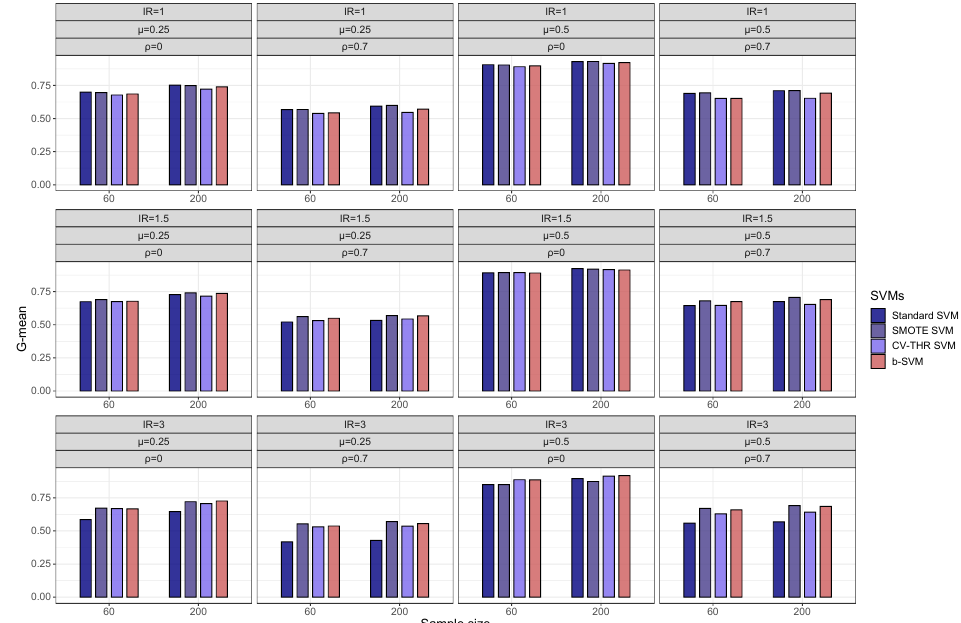
Figure 2. Classification performance (G-mean) of SVMs for simulated low-dimensional